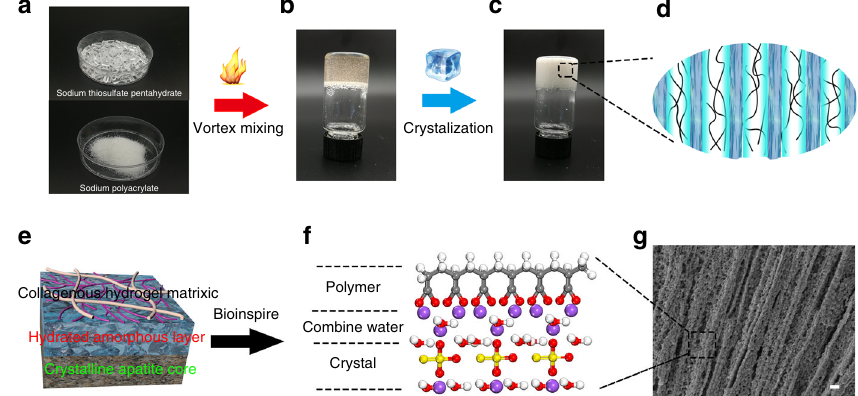
Fig. 1 Schematic illustration of the material synthesis. a Optical image of sodium thiosulfate pentahydrate and PAANa power. b Optical image of the composite in the castable state. c Optical image of the composite in the crystalline state. d Schematic diagram of the structure of the composite. e Schematic diagram of the interface in bones. f Molecular model of composite. g Scanning electron microscope of the ST crystals within the polymer network. Scale bar, 1 μ